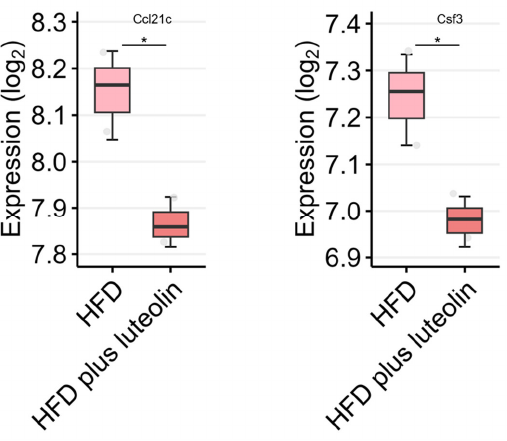
Figure 4. Comparison of Ccl21c and Csf3 expression in mouse muscle treated with HFD and with HFD plus luteolin. The gene expression of each cytokine/chemokine was analyzed using the GSE209778 dataset. *: p < 0.05 compared to the induction group.